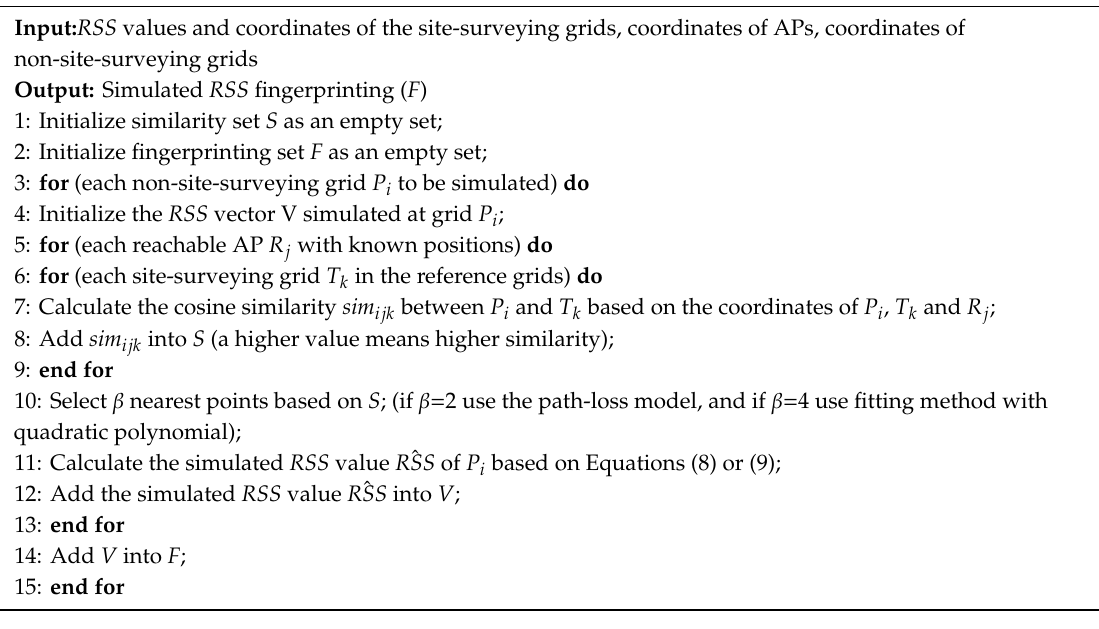
Algorithm 1 Pseudocode of SS-RSS Algorithm